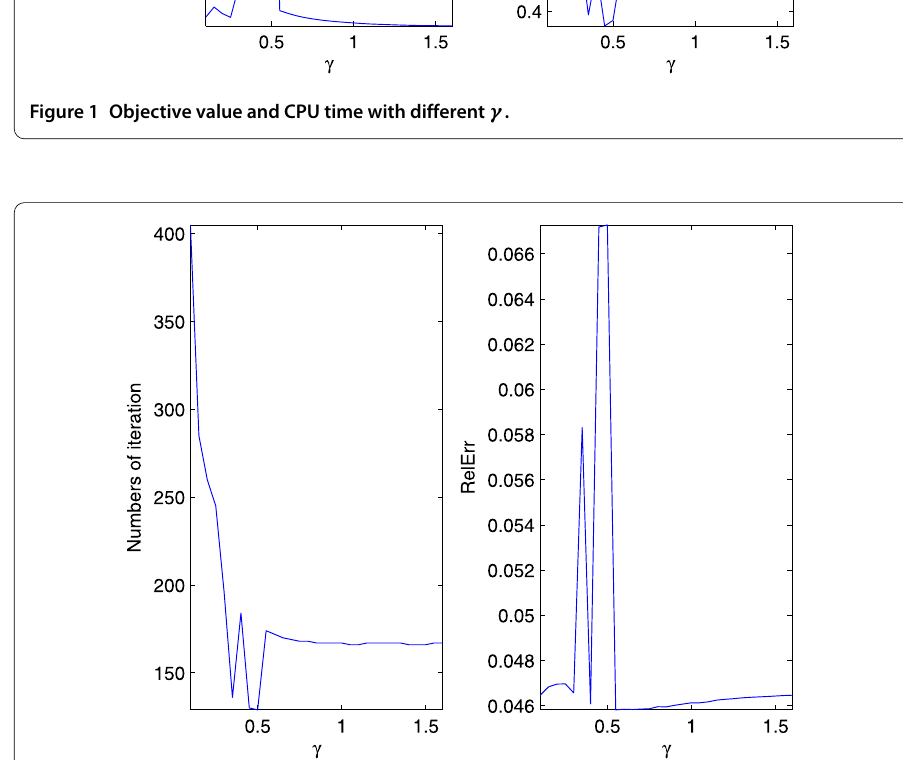
Figure 2 Numbers of iteration and relative error with different γ